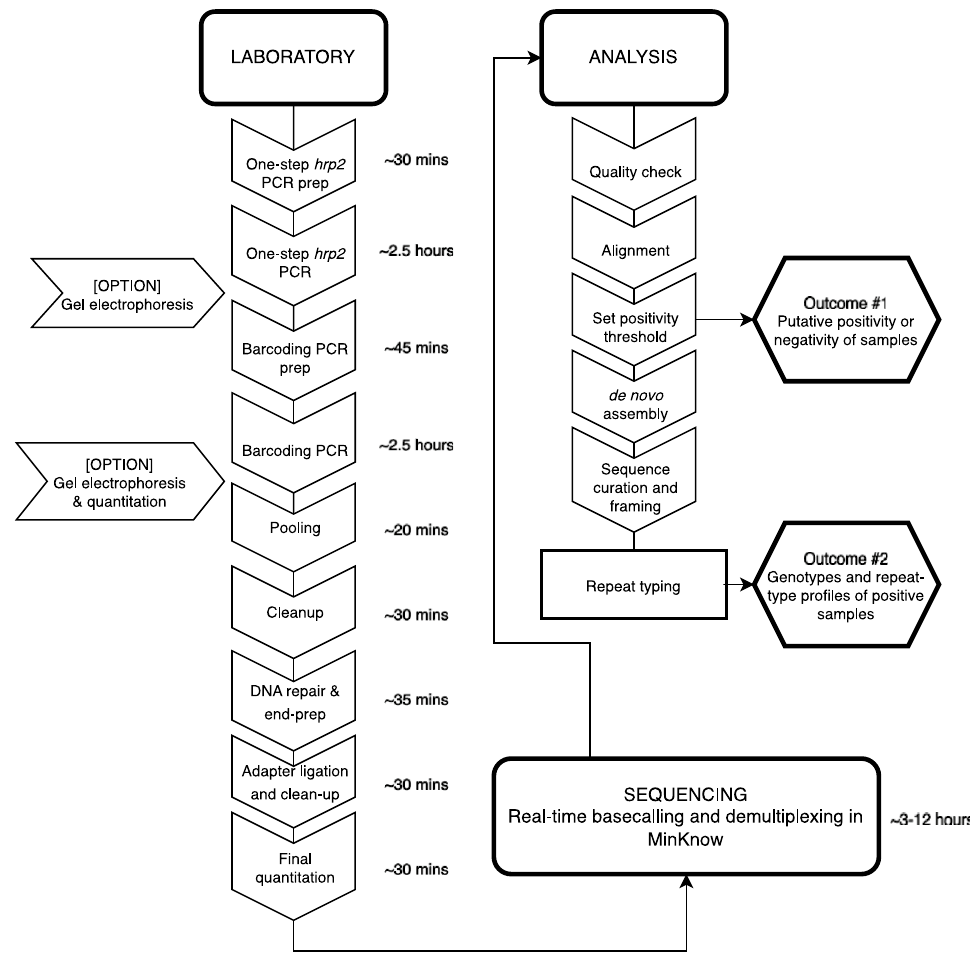
Figure 1. Workflow for field sample processing and analysis with the minION pfhrp2 assay. The optional steps of gel electrophoresis and pre-pooling quantitation were performed for quality control purposes. Time estimates are based on the researcher’s experience preparing a single pool of 5–10 samples, including a positive and negative control. See “Methods” for information on the processing of a subset of field samples for PacBio